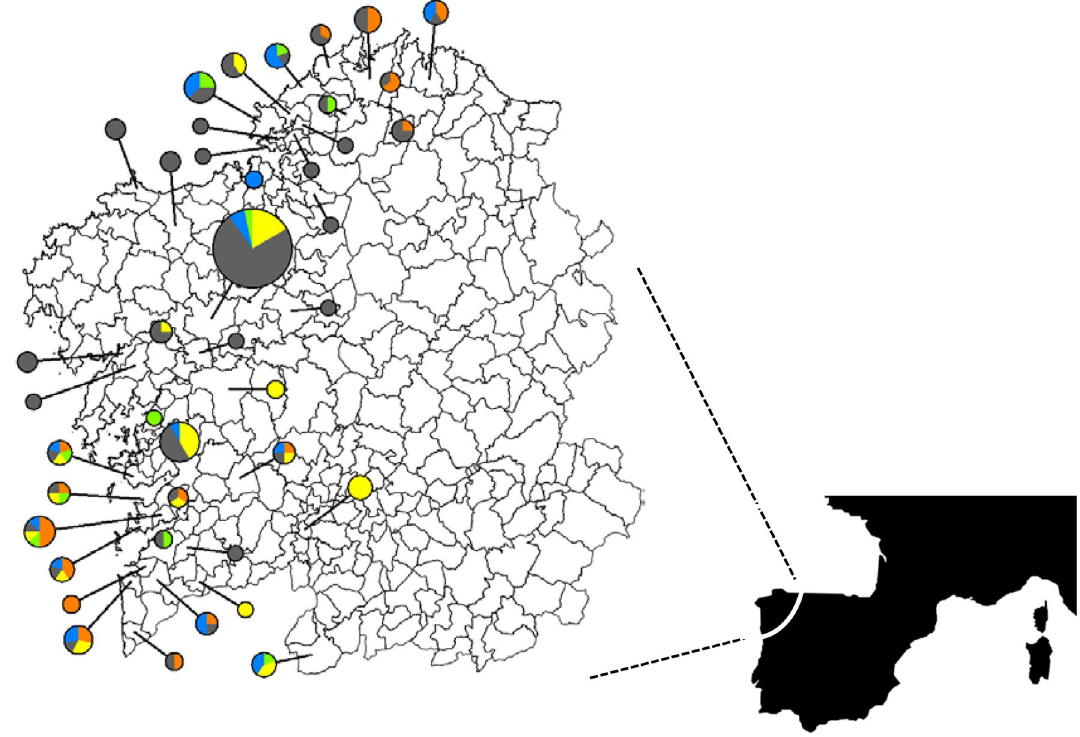
Figure 4. Geographic distribution of the samples. Circles identify the council of origin of the samples. Circles are drawn to scale to represent the number of samples and are color coded: V. velutina (grey), V. crabro (yellow), Vespula spp. (blue), Polistes spp. (green), Bombus spp. (orange). Map: South-West Europe and Galiza